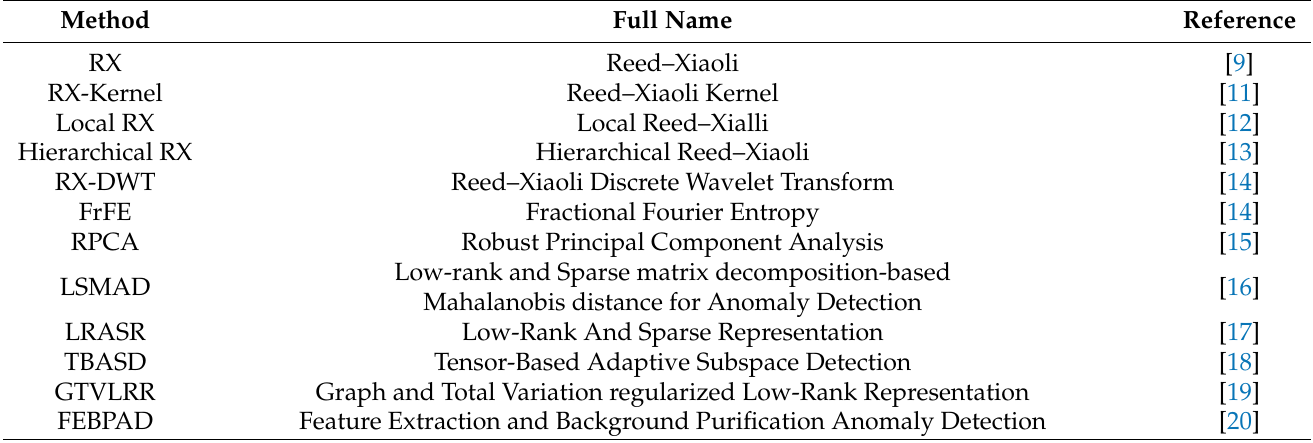
Table 1. Hyperspectral anomaly detection methods in the